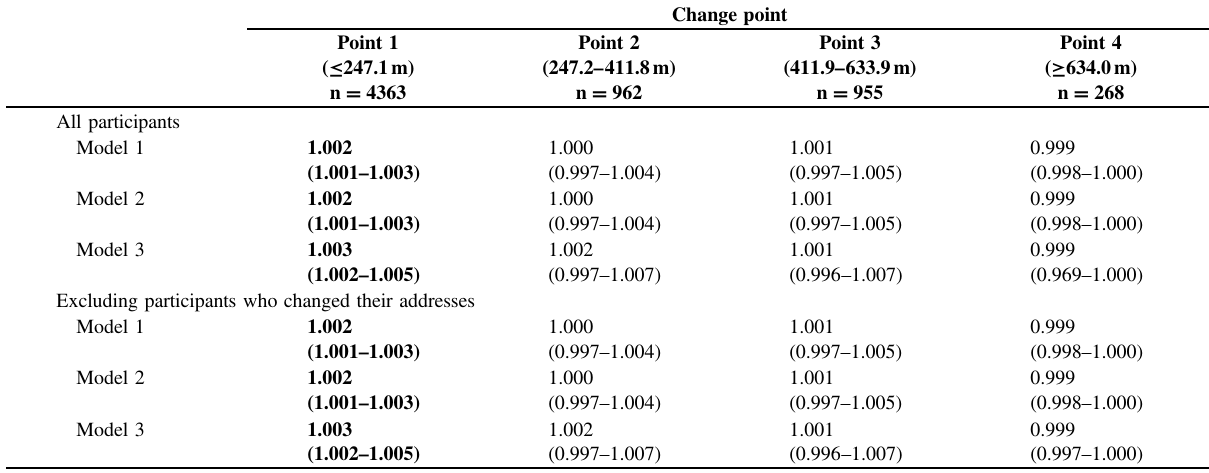
Table 3 Association between residential altitude and hypertension incidence among older adults included in this